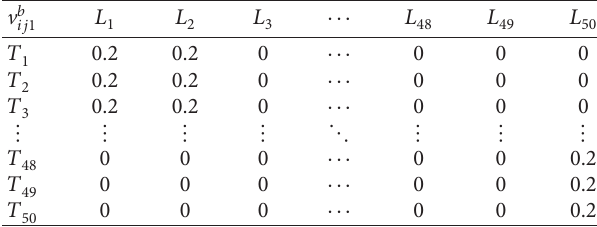
Table 16: Perceived utility matrix V b ′ � [ d ij ′ ] for 1 1 50 × 50 housing location.